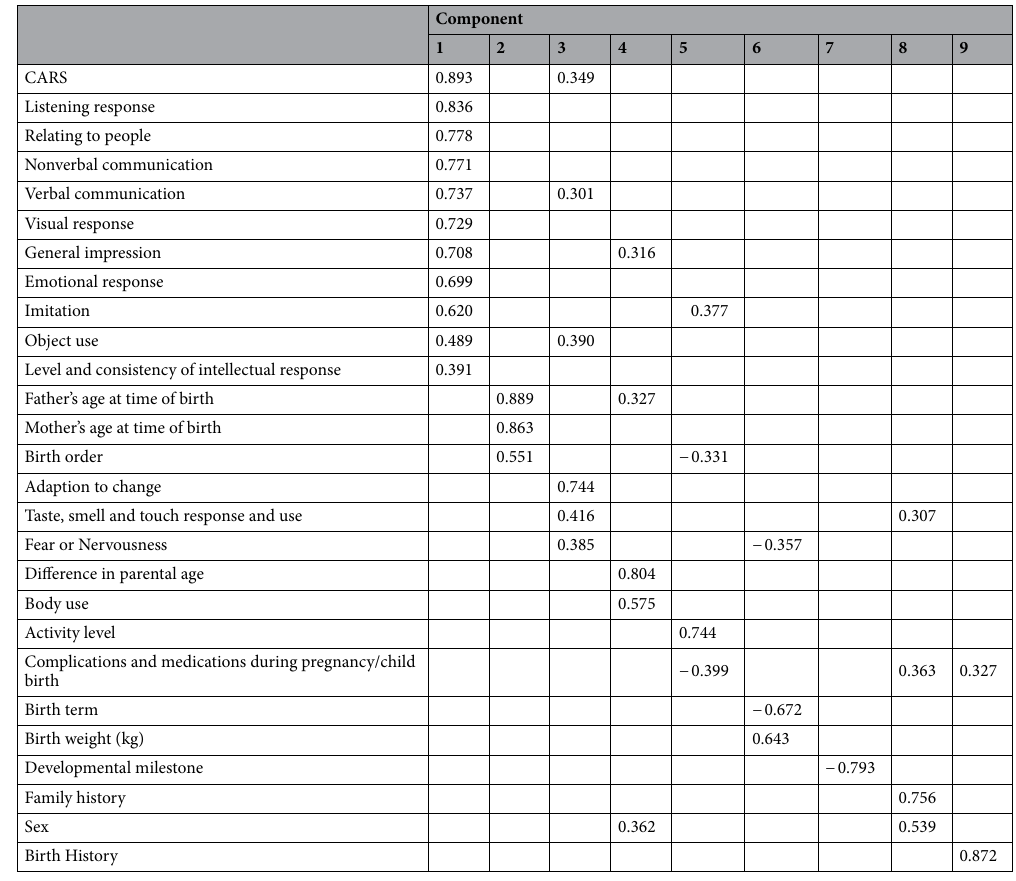
Table 3. Rotated component matrix a table. Extraction method: principal component analysis. rotation method: Varimax with Kaiser Normalization. a Rotation converged in 9